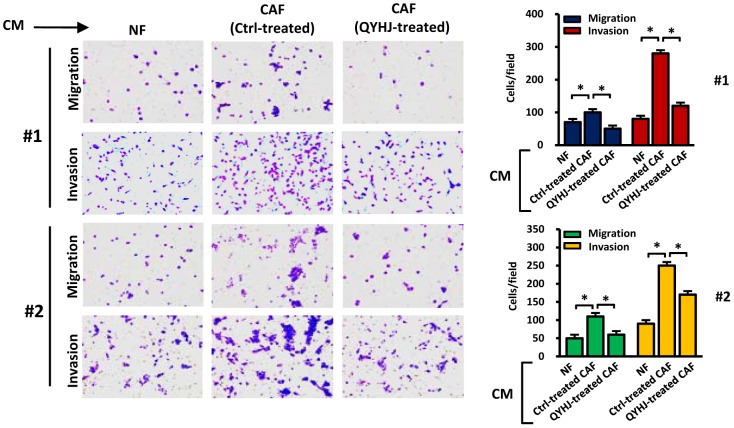
Pancreatic cancer cells treated using conditioned media from QYHJ-treated CAFs showed reduced invasion.The cell migration and invasion capacity of pancreatic cancer cells treated with conditioned media (CM) from NFs, Ctrl-treated CAFs and QYHJ-treated CAFs was compared using transwell chambers with or without Matrigel coating. The numbers of cells that traveled through the membrane were counted in 10 fields under a ×20 objective lens. Original magnification, ×200. The results represent the means ± SD of the values obtained in three independent experiments. Statistical significance was calculated using ANOVA. * P<0.05.